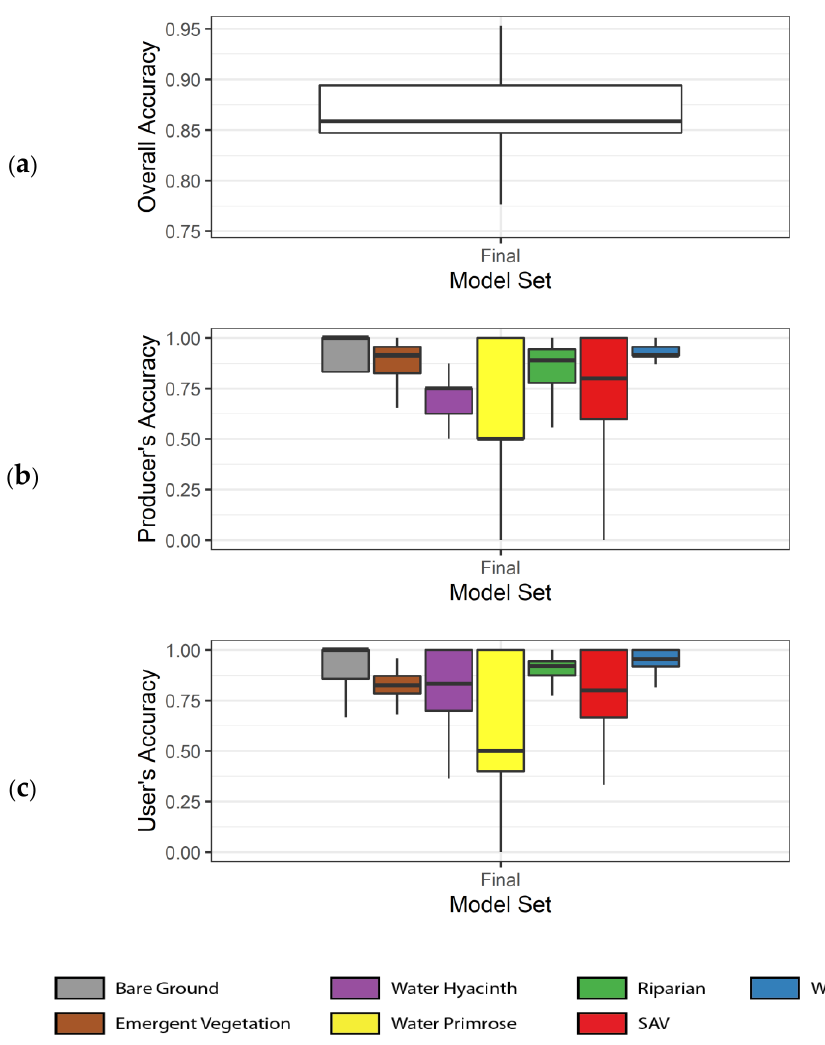
Figure 5. ( a ) Overall accuracy, ( b ) Producer’s accuracy, and ( c ) User’s accuracy ranges for all classes of the model set.